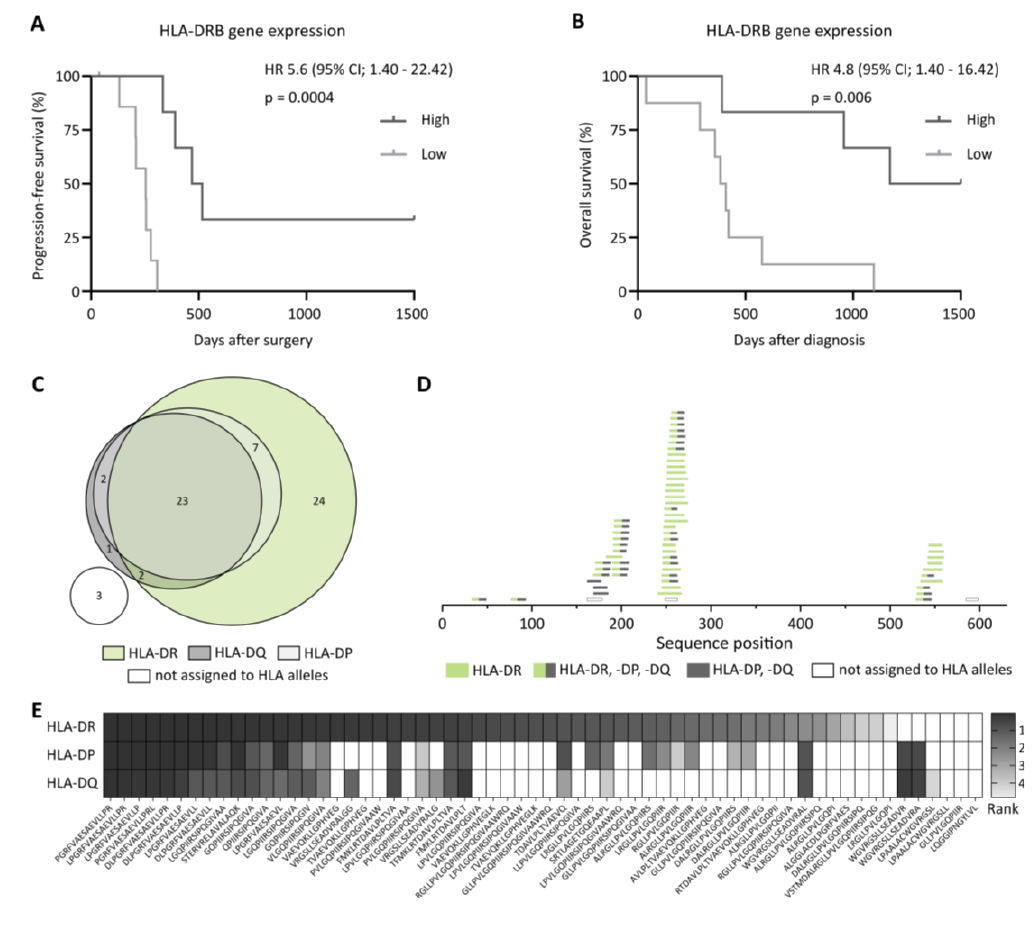
Figure 4. Impact of HLA-DRB gene expression on clinical outcome and in silico prediction of MSLN- derived peptide binding to HLA class II allotypes. ( A , B ) Impact of HLA-DRB gene expression level on ( A ) progression-free and ( B ) overall survival rates, according to low and high HLA-DRB gene expressions in the patients’ tumors. Median progression-free and overall survival in patients with a high HLA-DRB gene expression in their tumor was 493 and 1136 days after surgery or diagnosis, respectively. Kaplan – Meier analysis, log-rank test. ( C ) Overlap analysis of MSLN-derived peptides ( n = 62) predicted in silico to bind to HLA-DR, -DP or -DQ alleles. ( D ) Peptide clustering of HLA- presented peptides on the MSLN source protein sequence according to in silico predicted binding to HLA class II allotypes. Peptides are grouped according to their predicted binding to different alleles of HLA-DR, -DP or -DQ. Peptides marked in green are predicted to bind exclusively to HLA- DR alleles. ( E ) Heat map depicting the percentile rank of the prediction scores for MSLN-derived peptides ( n = 62) according to HLA-DR, -DP and -DQ allele groups. For each group, the rank of the best predicted allele is shown. Peptides are sorted by descending binding to HLA-DR alleles. Pep- tides with a percentile rank <1 are identified as strong binders, peptides with a percentile rank <5 as weak binders. The gradient ranges from strong HLA binding (dark gray) over weak HLA binding (light gray) to no HLA-restricted peptide binding (white). Abbreviations: HR, hazard ratio; CI, con- fidence interval; and p : p -value.